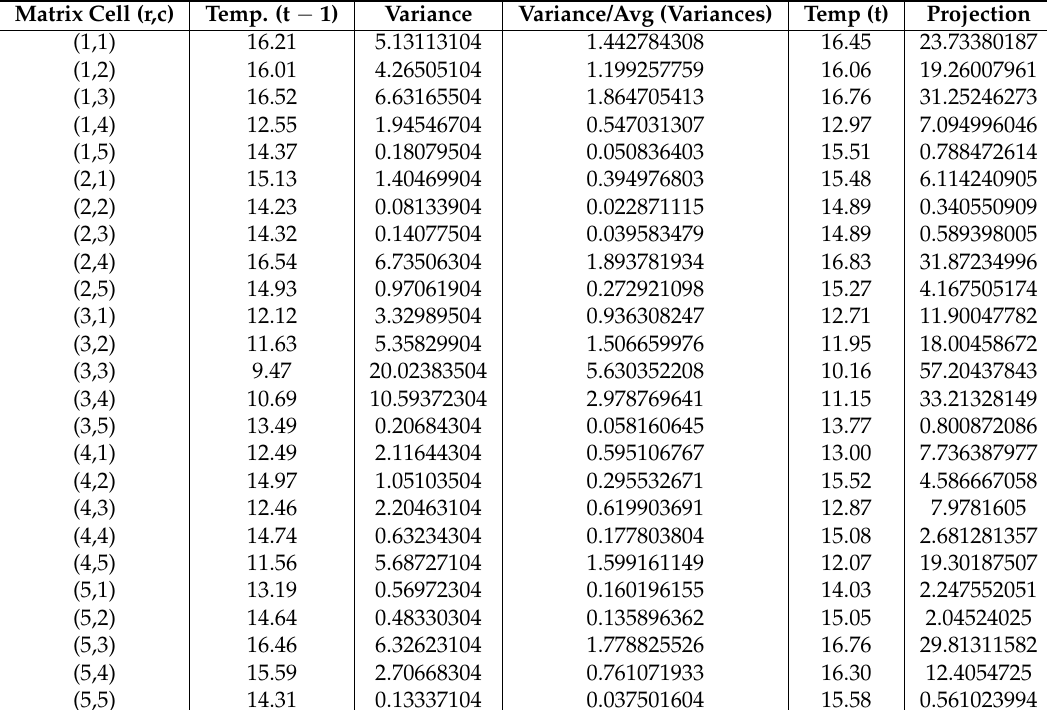
Table 9. Table explaining the representation basis. Starting from the temperature taken in each area of the RoI in the previous instant represented by (row, column), we generate the variance (2nd column), then in the 3rd column we divide the variance per the average of them. Finally, in the 5th column, we represent the temperature obtained in the current timestamp (4th column) multiplying them by the corresponding values of the 3rd column.